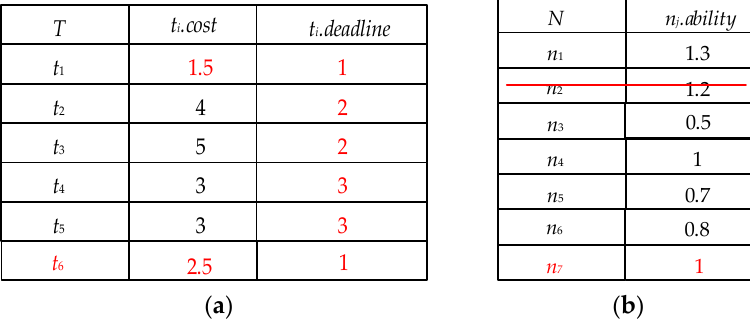
Figure 3. Task list and volunteer nodes list at time l 1 + 1. ( a ) List of tasks at time l 1 + 1; ( b ) list of volunteer nodes at time l 1 + 1.